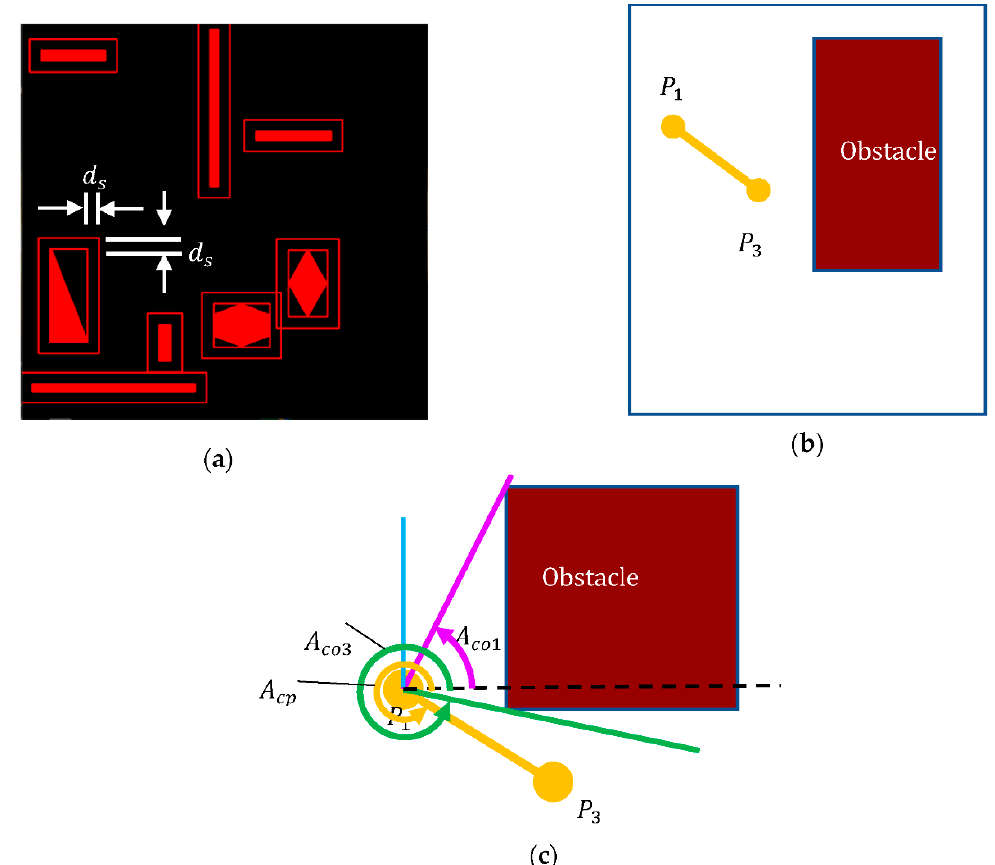
Figure 3. ( a ) The obstacle definition by a rectangle boundary with safety d s . Illustration of collision detection when two checkpoints P 1 and P 3 are ( b ) at the same side or ( c ) at different sides of the obstacle. The latter then requires calculation of the angle A co 1 , A co 2 , and A cp in a collision